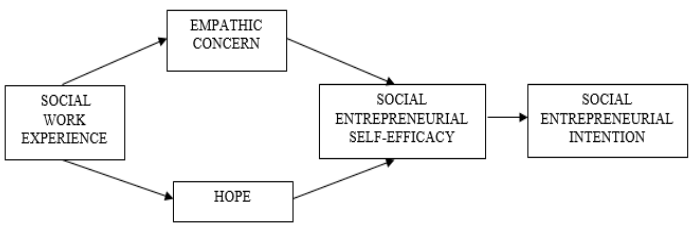
Figure 1. Conceptual Model.